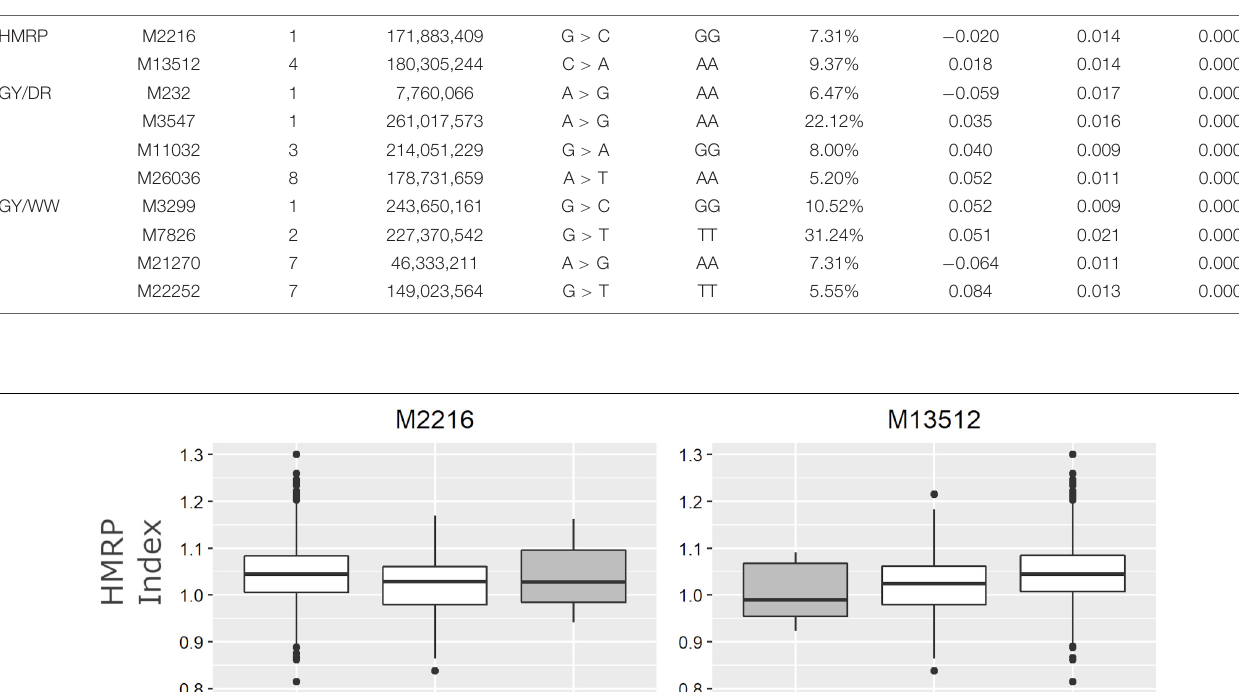
Frontiers in Plant Science |